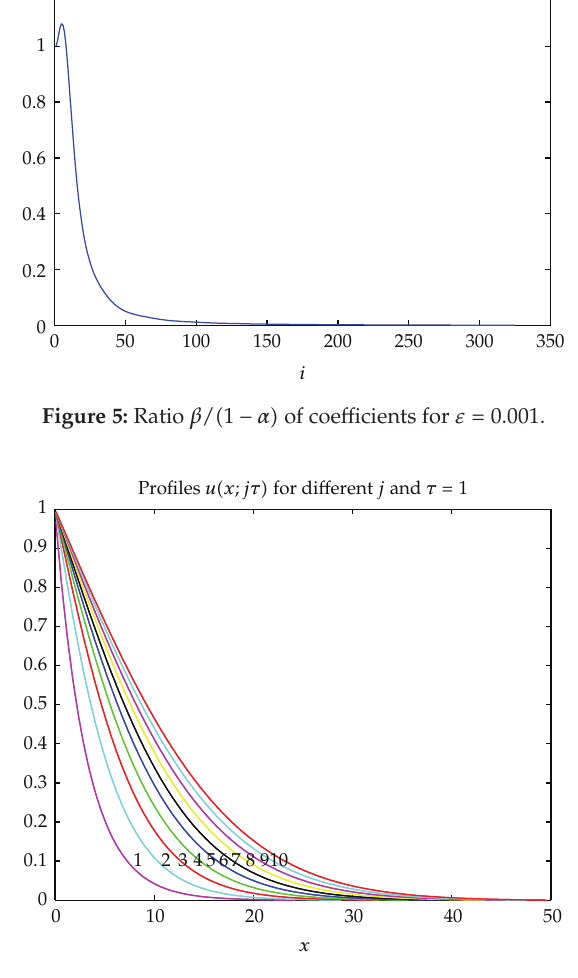
Figure 6: u (cid:2) x,t j (cid:3) by infinite